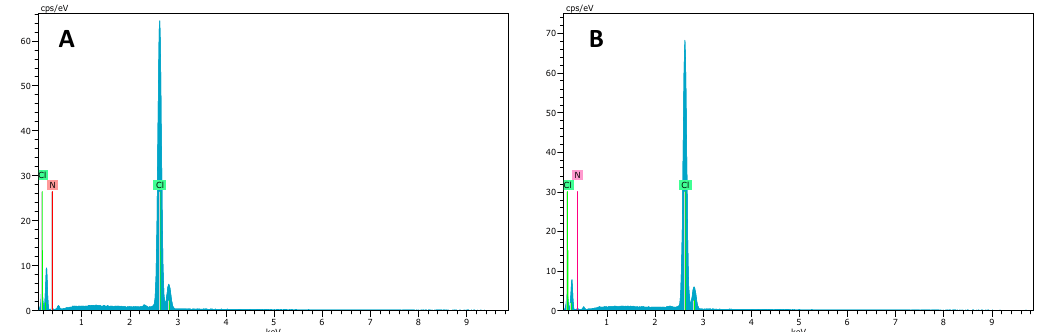
Figure 4. Energy-dispersive X-ray (EDX) analysis of membranes containing 70% w / w ( A ) and 30% w / w of IL ( B ) before being used.